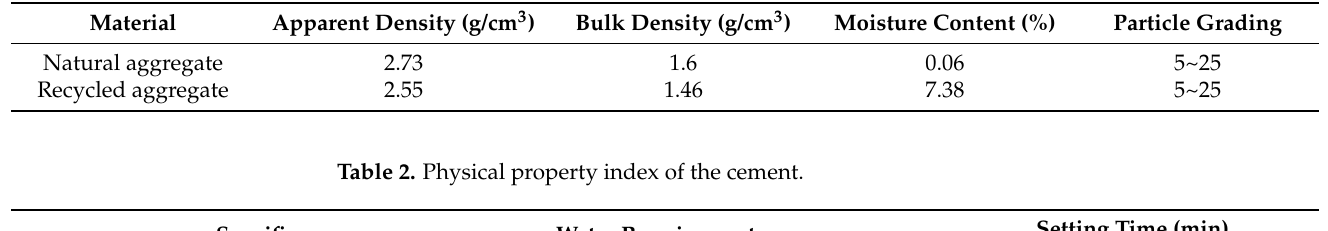
Table 1. Physical property of the coarse aggregates.